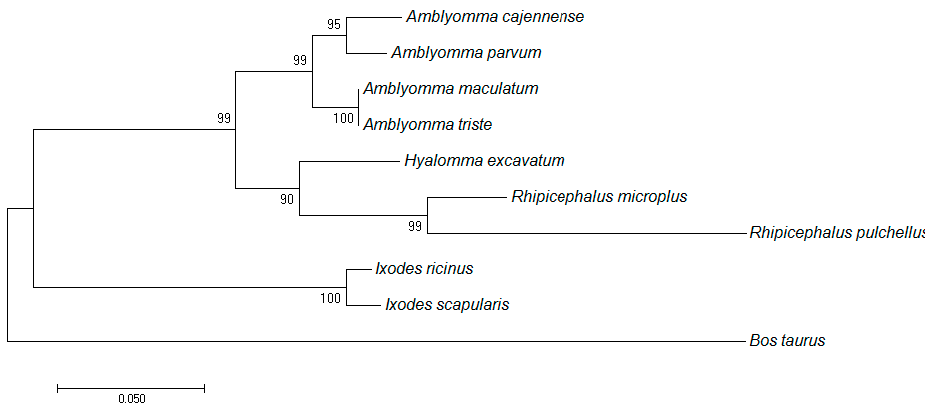
Figure 1. Molecular phylogenetic analysis of triosephosphate isomerase (TIM) sequences. The evolutionary history was inferred by using the maximum likelihood method. Sequences from different tick species and also the Rhipicephalus microplus -specific host ( Bos Taurus ) were included in the analysis.